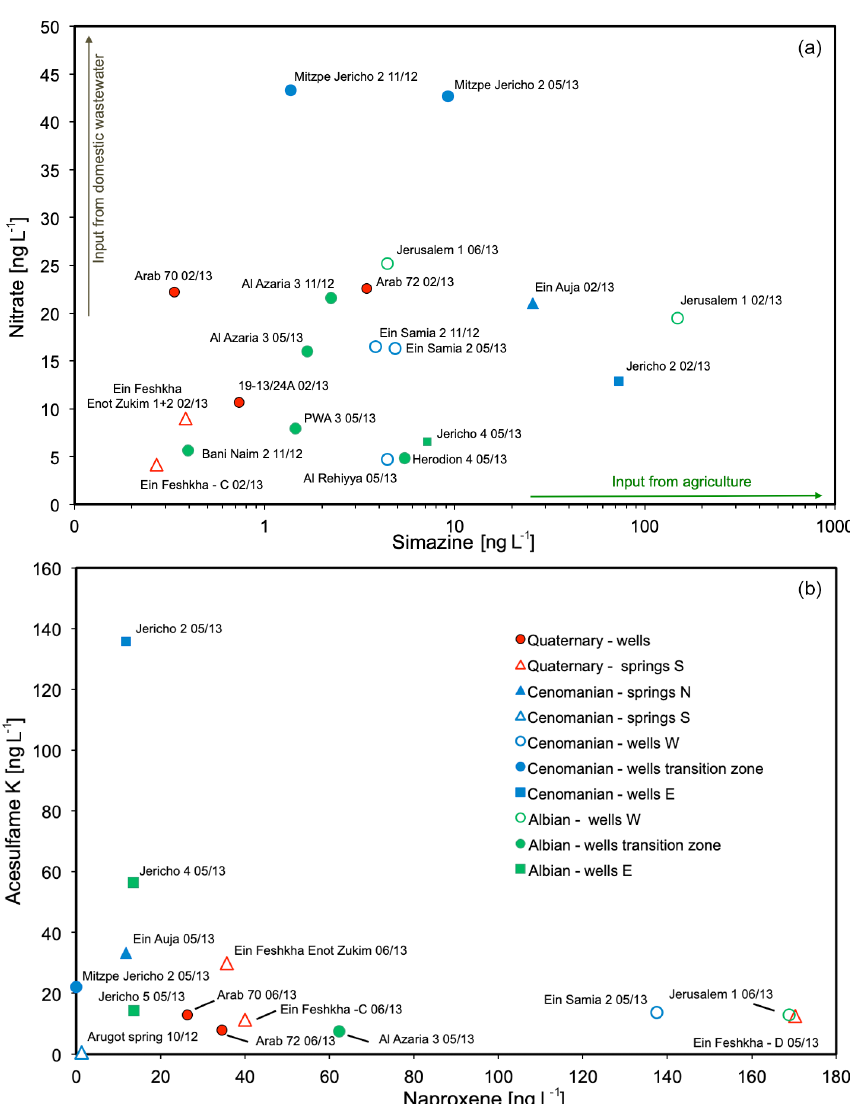
Figure 4. Cross plots of (a) NO 3 and simazine in sampled waters, suggesting different sources of both pollutants; the blue and green lines respectively bracket coloured spaces and indicate the fields in which samples from Upper Cenomanian and Albian aquifer plot are taken; and (b) acesulfame K and naproxen are indicators for wastewater (treated and untreated) in the sampled waters. Legend for both figures is given in (b)